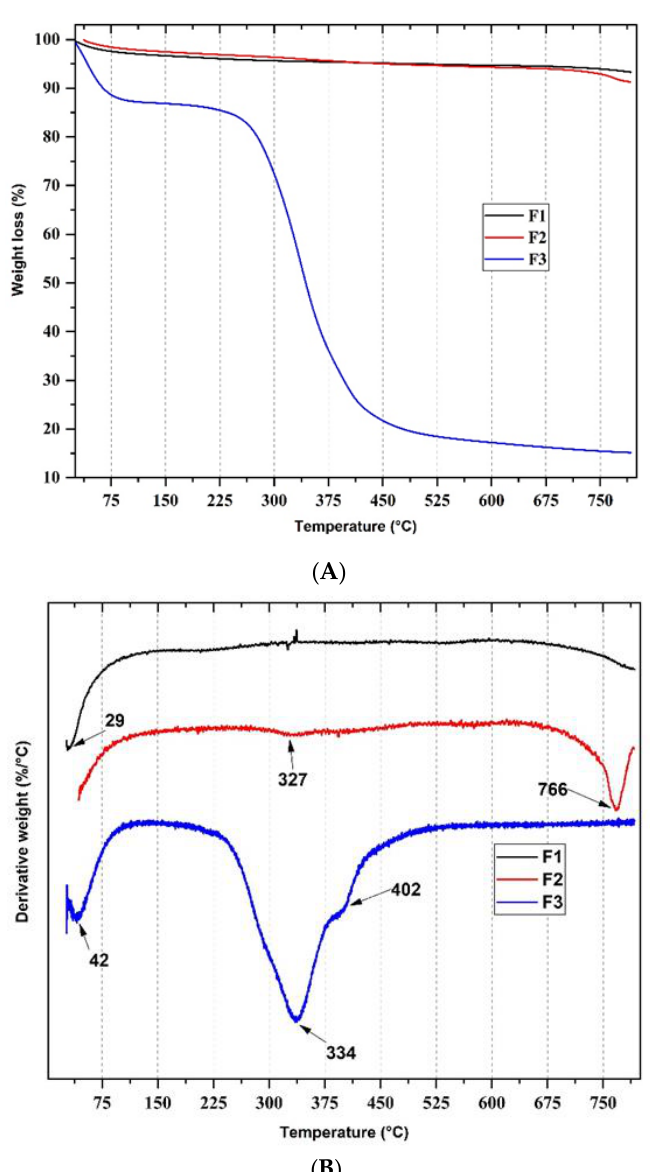
Figure 2. TGA and DTGA analysis of F1, F2, and F3. According to Table 1, F1: InterOss. F2: InterOss Collagen. F3: InterCollagen Guide. ( A ) Thermogravimetric analysis (TGA). ( B ) Derivative TGA. Differential Scanning Calorimetric (DSC)